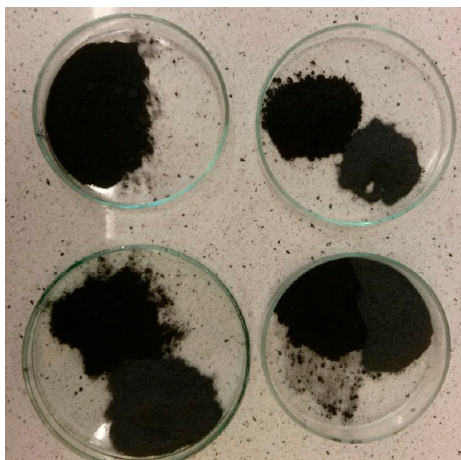
Table 4. Temperature values of successive degradation stages.